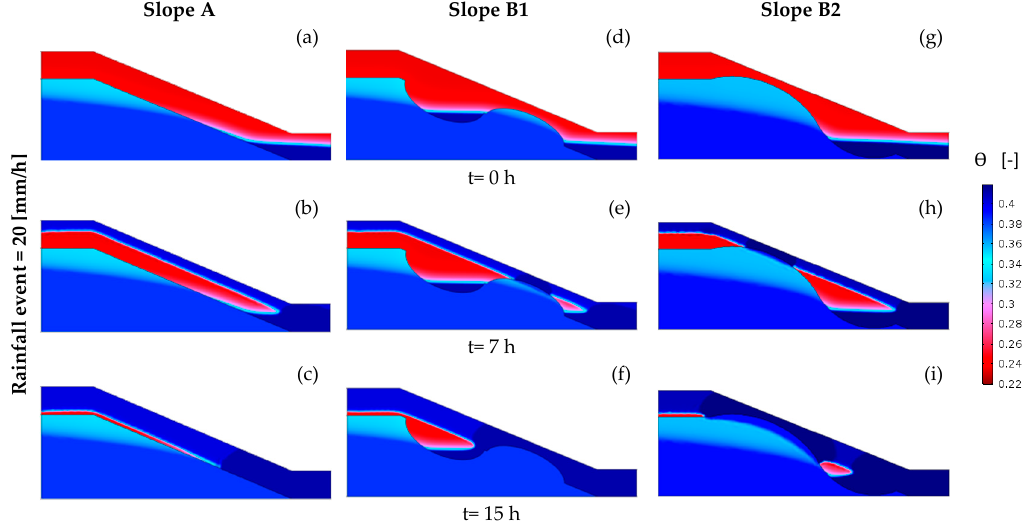
Figure 8. The temporal development of the soil water content distribution for a 15 h rainfall event with an intensity of 20 mm per hour for the 2D slope with a constant soil depth (slope A) at ( a ) t = 0 h, ( b ) t = 7 h, and ( c ) t = 15 h, and the 2D slopes with variable soil thickness (Slope B1 and B2) at ( d , g ) t = 0 h, ( e , h ) t = 7 h, and ( f , i ) t = 15 h.